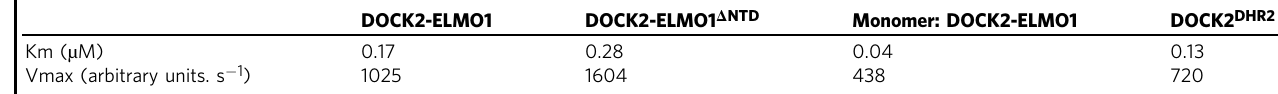
Table 1 Initial rate constants of nucleotide exchange reactions of DOCK2-ELMO1